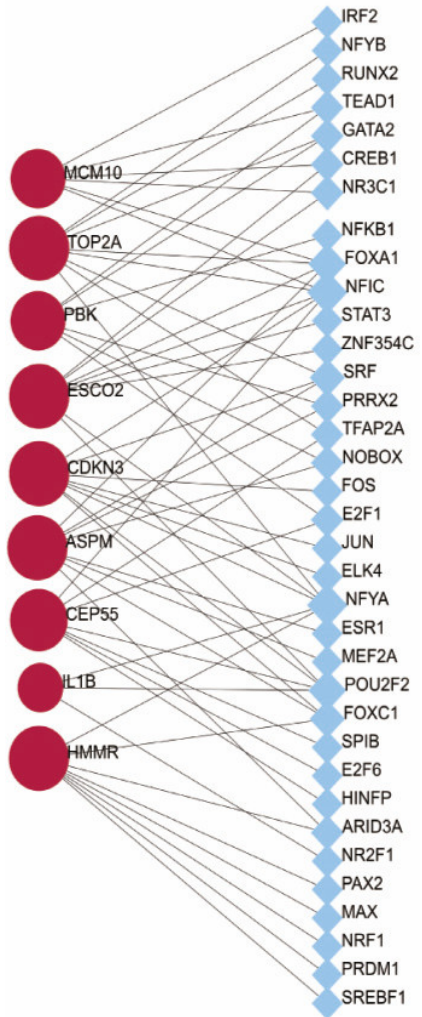
(Figure 6). ESCO2, ASPM, HMMR, CDKN3 and TOP2A were found to be regulated by eight TFs, while CEP55 was found to be regulated by seven TFs, PBK and MCM10 by six TFs and IL1B by three TFs. In addition, various TFs were found to regulate more than one hub gene and fifteen TFs were identified with a connectivity degree ≥ 2 in the gene–TF regulatory network, which means that these TFs have close interactions with these hub DEGs. For example, nuclear factor I-C (NFIC) was predicted to regulate MCM10, TOP2A, ESCO2, CDKN3 and CEP55 ; nuclear transcription factor Y, subunit A (NFYA) was found to regulate TOP2A, ESCO2, CDKN3, IL-1 β and HMMR. Identifying the expression of key transcription factors is critical for directing psoriasis gene expression and participating in its physiopathological processes.